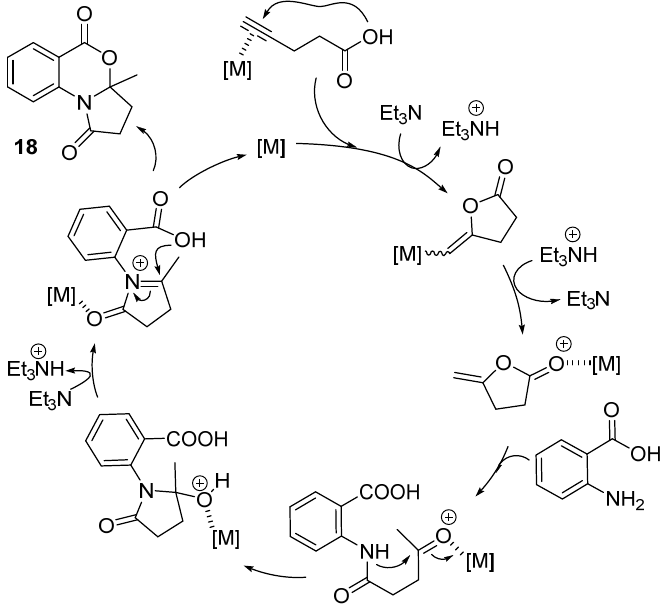
Figure 4. Proposed catalytic pathway for the cascade reaction performed in the presence of a palla- dium pincer complex and iron(II) bromide. palladium pincer complex and iron(II)